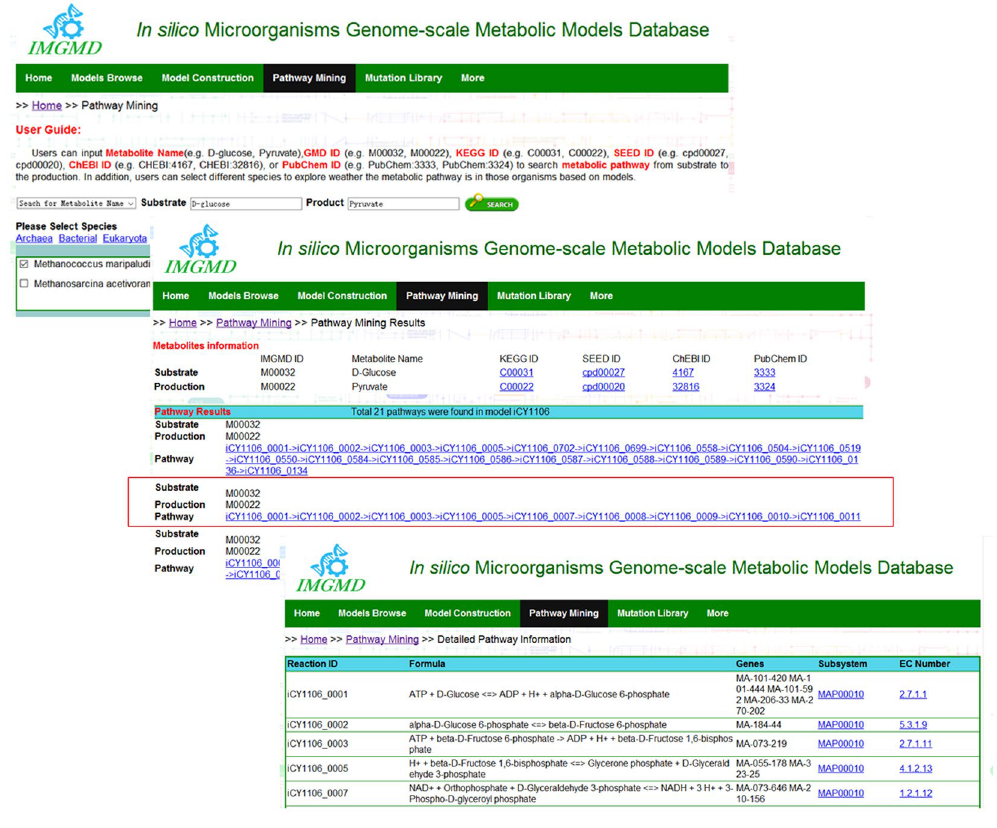
Figure 4. Pathway mining results for the i CY1106 model from glucose to pyruvate. A summary of all pathways found in the i CY1106 model from glucose to pyruvate, and detailed reaction information for a pathway in model i